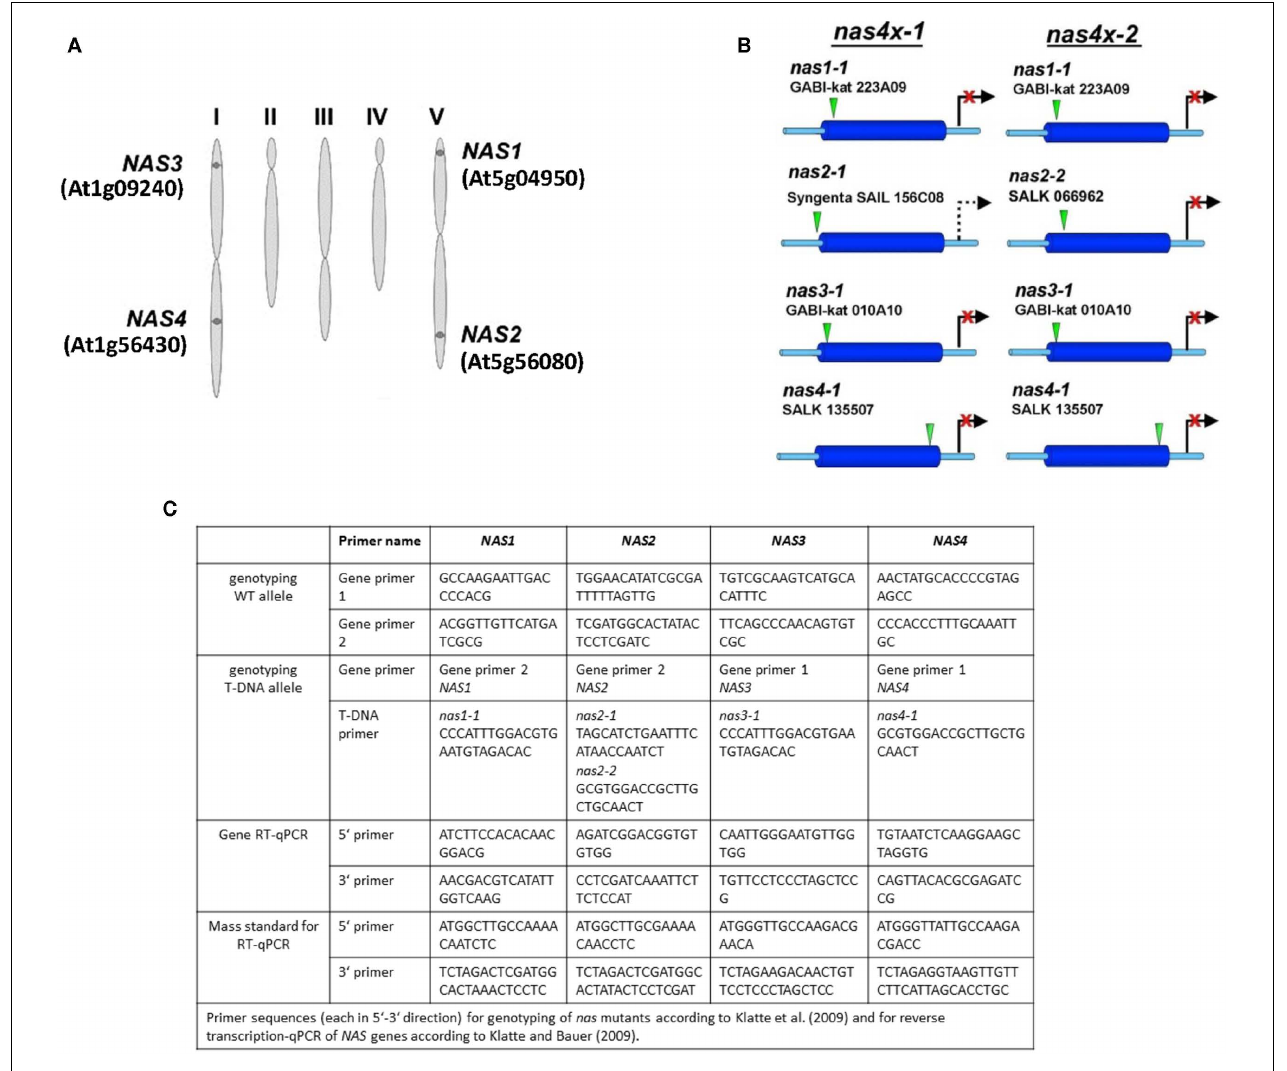
It is shown which alleles are combined in the quadruple mutants nas4x-1 and nas4x-2 (Klatte et al., 2009). (C) Table listing the primers used for genotyping as described in (Klatte et al., 2009) and the primers used for gene expression analysis by reverse transcription-qPCR according to (Klatte and Bauer,